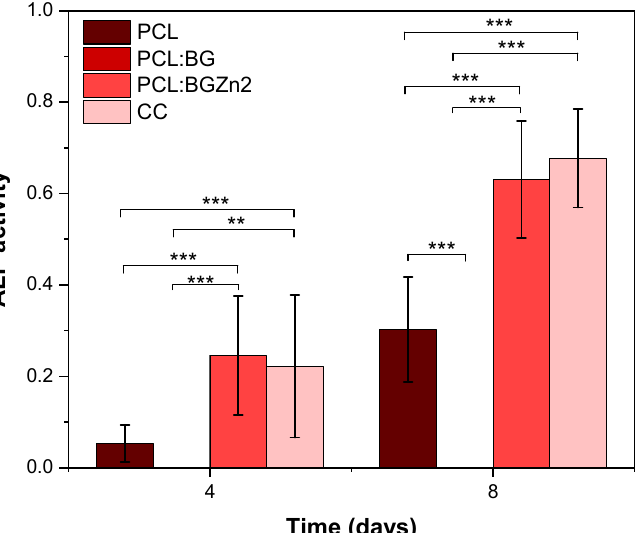
Figure 11. ALP production on days 4 and 8 for PCL, PCL:BG and PCL:BGZn2 membranes (** p < 0.01 and *** p < 0.005).